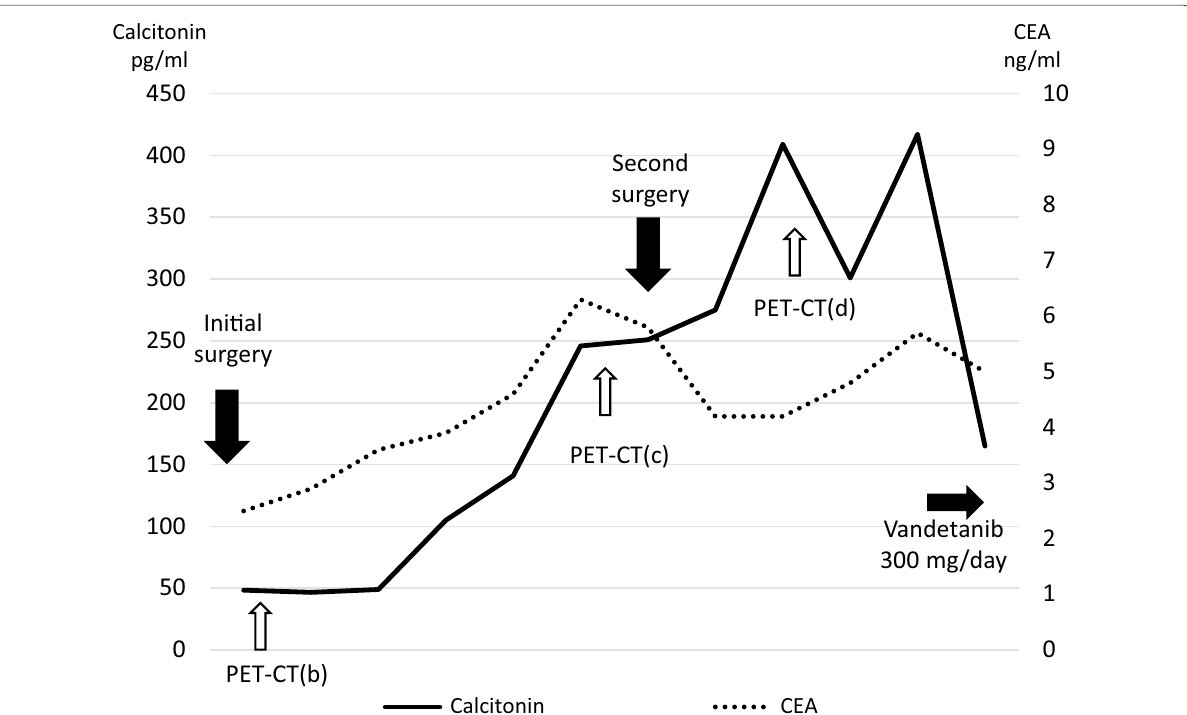
Fig. 2 Blood test results and progress of treatment. Serum calcitonin level increased after the second surgery. Serum CEA level stayed as high as around upper limit of normal range. PET–CT (b to d) correspond to Fig.